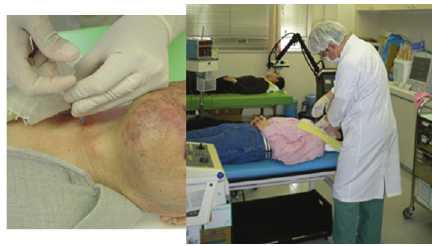
Figure 13: Stellate ganglion block.